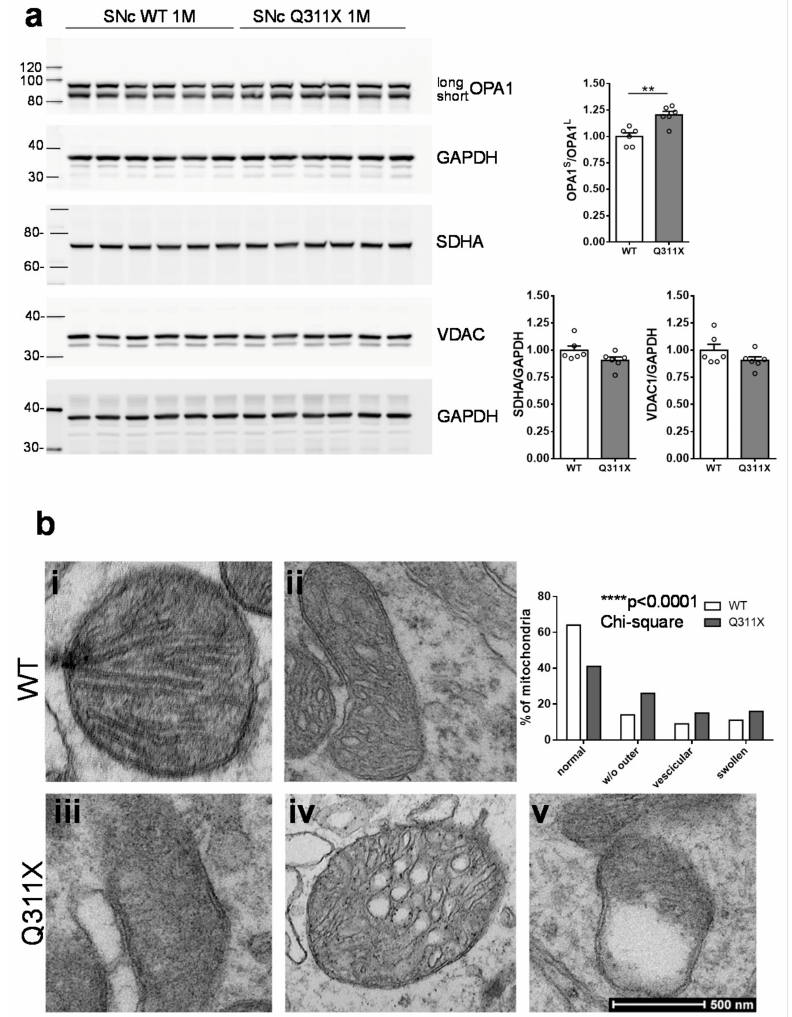
Figure 3. Expression of the human parkin variant parkinQ311X induces early mitochondrial dys- function in SNc DA neurons. ( a ) Representative Western blots showing the levels of mitochondrial proteins (OPA1, SDHA, VDAC) in lysates prepared from the substantia nigra of WT or parkinQ311X mice at 1 month of age. Samples were run in triplicate, with each lane loaded with lysate from an individual mouse. The histograms on the right show the mean ± SEM calculated from densitometer quantification (** p < 0.01 unpaired Student’s t -test). ( b ) Representative TEM images showing mito- chondria in SNc DA neurons of WT (control, i,ii ) and parkinQ311X ( iii,iv,v ) mice. The mitochondria in control specimens show the typical rounded/tubular morphology ( i,ii ). The mitochondria in parkinQ311X mice display marked ultrastructure disruption ( iii,iv,v ) and a lack of the typical crystal organization found in the control tissue: 26% of the mitochondria in parkinQ311X DA neurons displayed an almost complete loss of outer membrane shape and form ( iii ). Other mitochondria in the parkinQ311X DA neurons retained outer membrane integrity but demonstrated ultrastructural damage: dilation of intracrystal spaces, loss of matrix density, and deposits of electron-dense material within the matrix (vesicular mitochondria) ( iv ). Swollen, clear mitochondria showed herniation of the swollen matrix covered by the inner membrane through the ruptured regions of the outer membrane ( v ). The histograms on the right show the distribution of morphological features. For each section we counted the number of mitochondria with normal morphology, those with loss of outer membrane, those with vesicular morphology, and the swollen ones. WT and parkinQ311X mice ( n = 3 in each group) were analyzed: total count n = 246 for WT and n = 320 mitochondria for parkinQ311X mice. There was a statistically significant difference in the distribution of WT and parkinQ311X neurons (**** p < 0.0001, df 3, chi-square